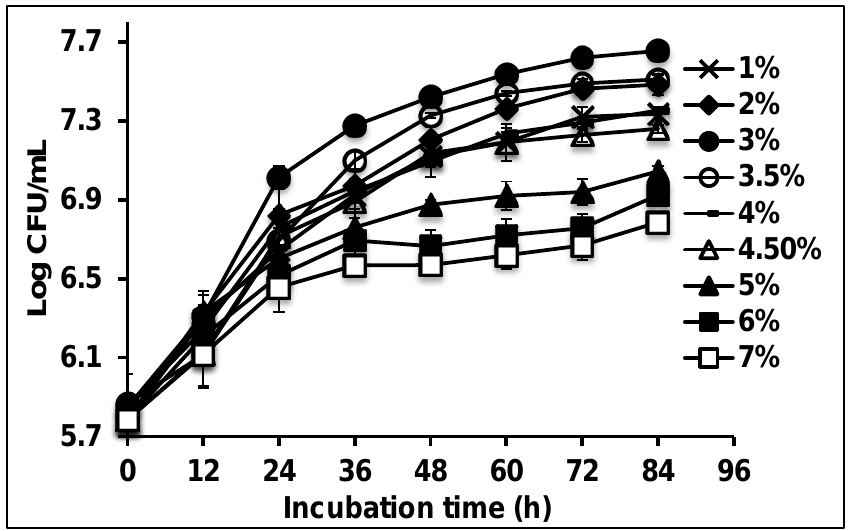
Figure 5. Effect of different initial canola oil concentrations on growth in Rhodococcus erythropolis Figure 5. E ff ect of di ff erent initial canola oil concentrations on growth in Rhodococcus erythropolis AQ5-07. Error bars represent mean ± standard deviation, 𝑛 = 3. AQ5-07. Error bars represent mean ± standard deviation, n =